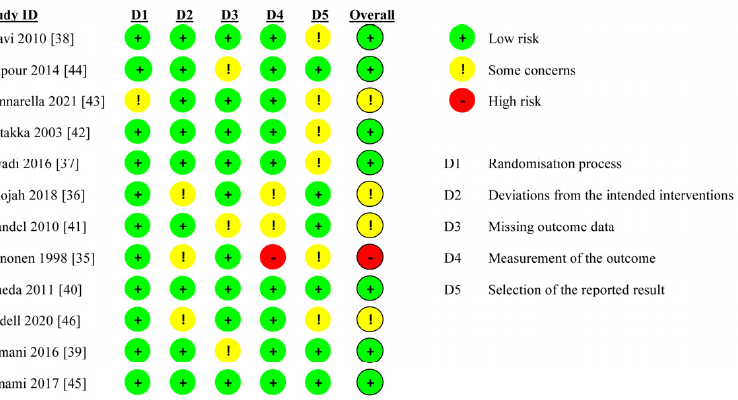
Figure 2. Summary of risk-of-bias judgments within each bias domain of the Cochrane Collaboration tool [35–46].